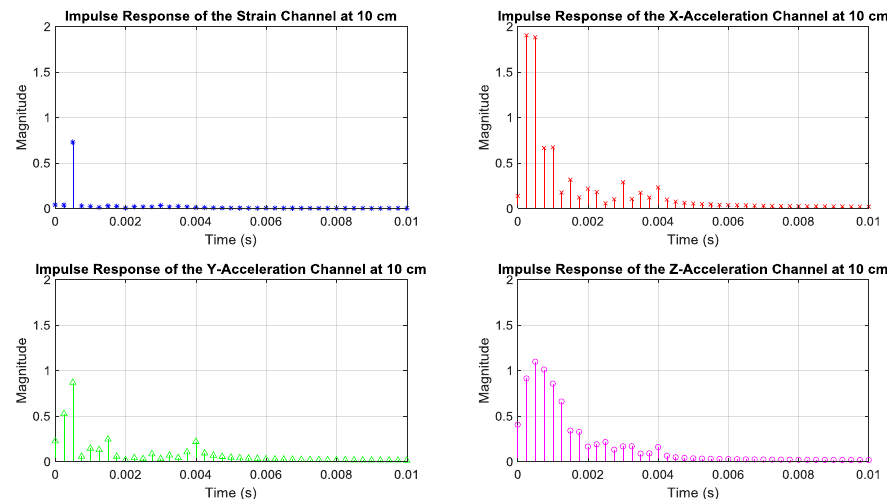
Figure 3. Magnitudes of impulse responses of the channels measured by the receiving sensors in Figure 1b.